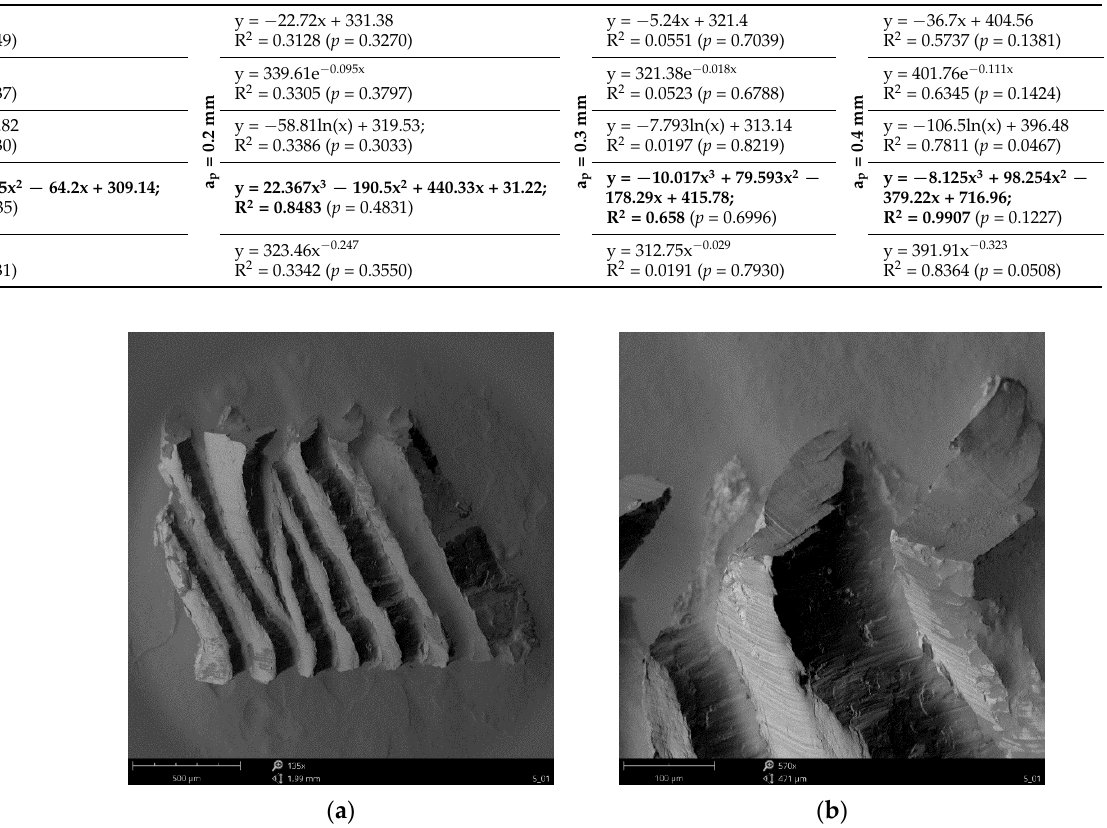
Figure 11. SEM imaging of a magnesium alloy chip surface on the free side ( a ) slip plane and ( b ) material decohesion.